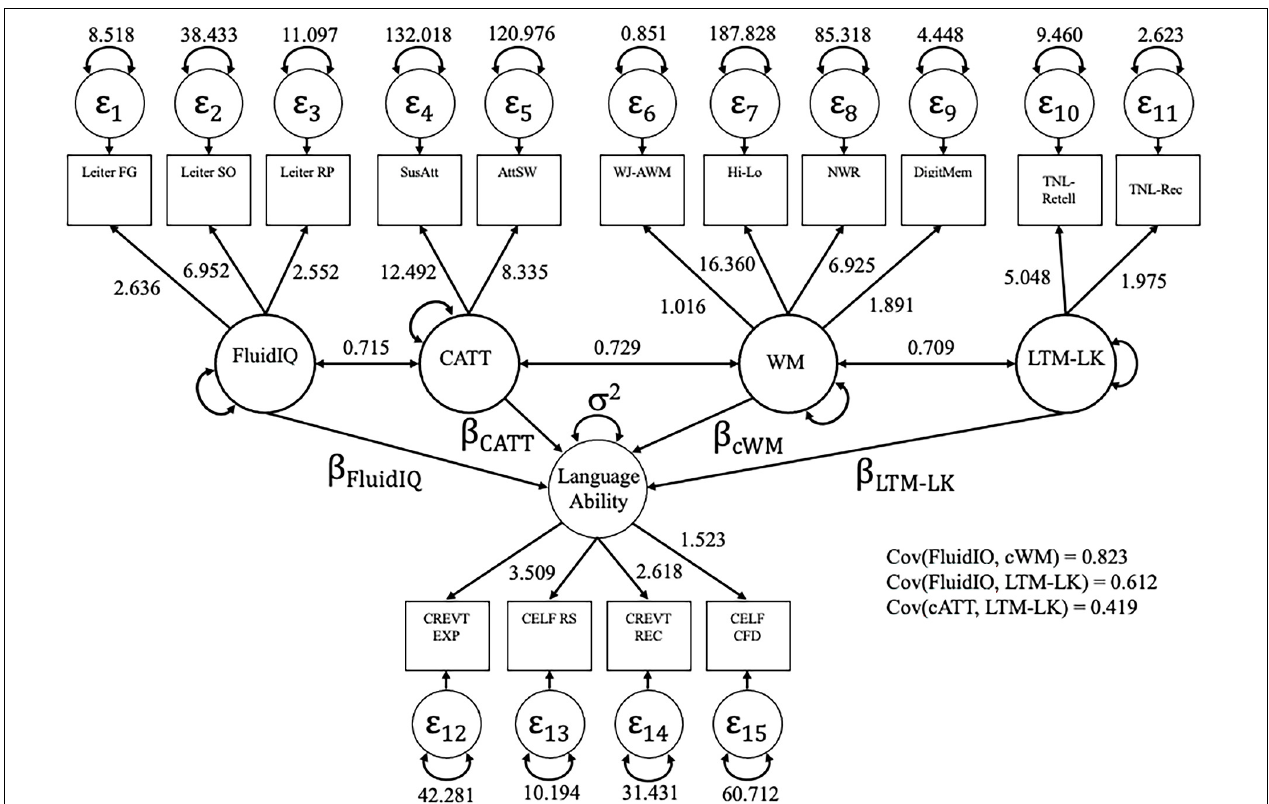
FIGURE 4 | The five-factor measurement model containing the latent variables of fluid reasoning (FLDR), controlled attention (CATT), working memory (WM), long-term memory – language knowledge (LTM-LK) and language. TABLE 4 | Regression estimates and standard errors across groups from Figure 4 . TD